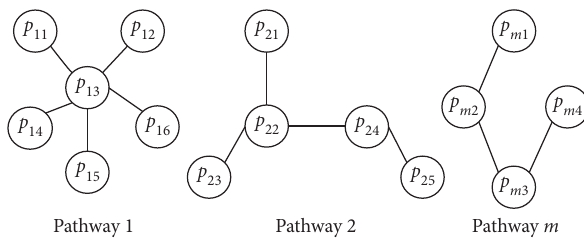
Figure 3: Schematic diagram of